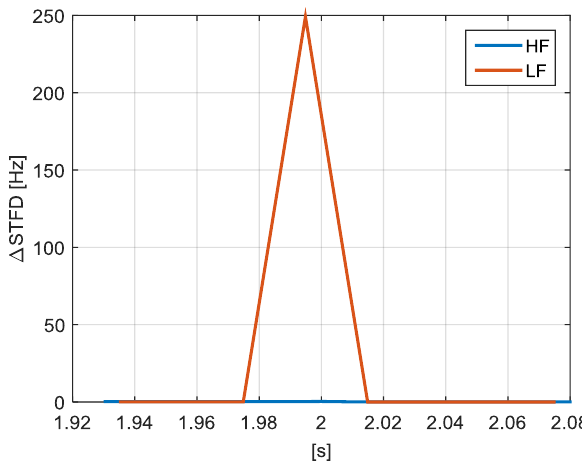
Figure 22. Case study 3: STDE at low-frequency (0 ÷ 2.4 kHz, red line) and at high-frequency (2.4 ÷ 150 kHz, blue line) obtained through the late approach.